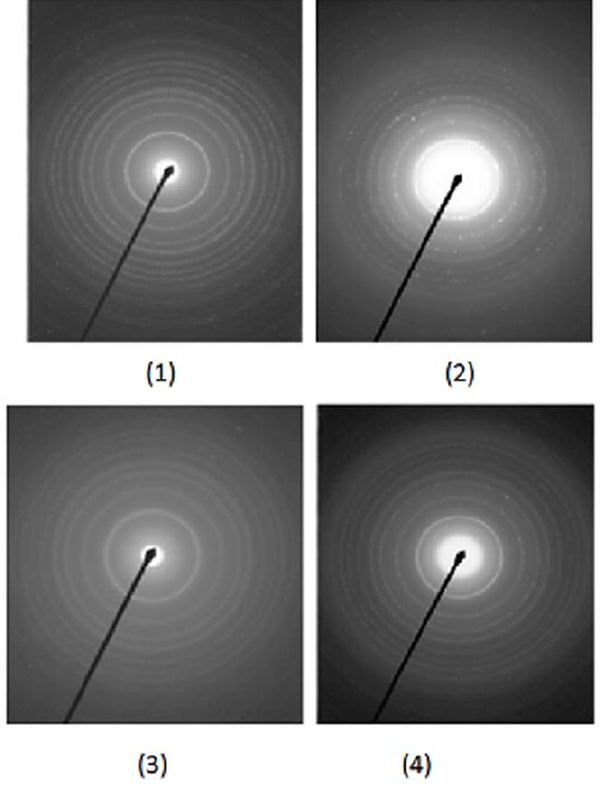
Figure 6. ED images of the samples, (1) sample 1 calcinated at 400 6 C, (2) sample 2 calcinated at 400 6 C, (3) sample 1